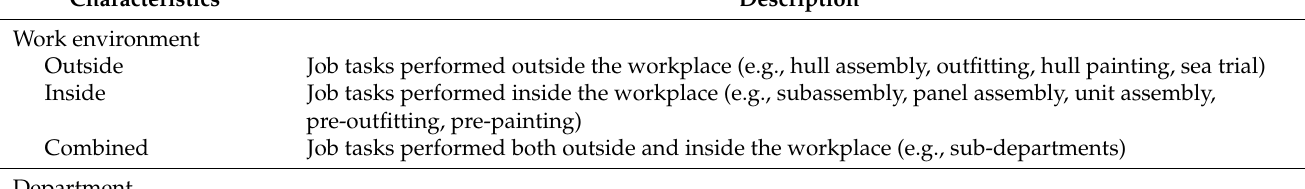
Table 1. Characteristics of work environment, department, employment type, and occupation (job task) in the shipbuilding process in